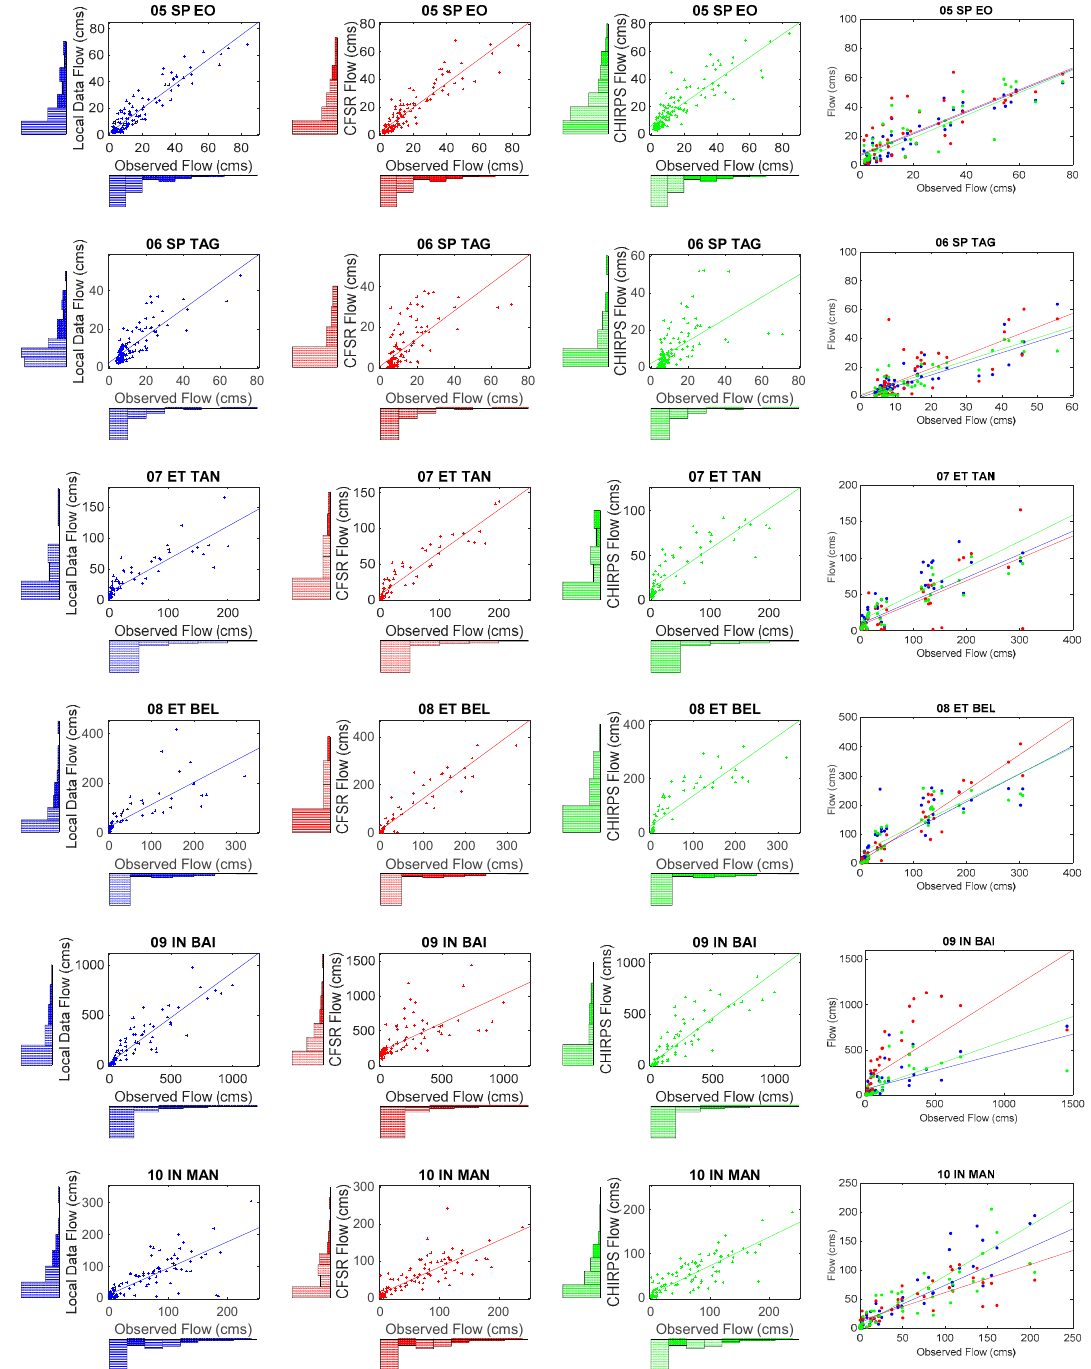
Figure 6. Relationship between the observed and simulated data for accumulated monthly streamflow. The calibration process and is separate for each rainfall input (local data, CFSR, and CHIRPS, respectively) represented by the combination of the histogram and scatter plots. The scatter plot alone represents the validation process for the three inputs together (for interpretation of the references to color in this figure legend, the reader is referred to the web version of this article.).